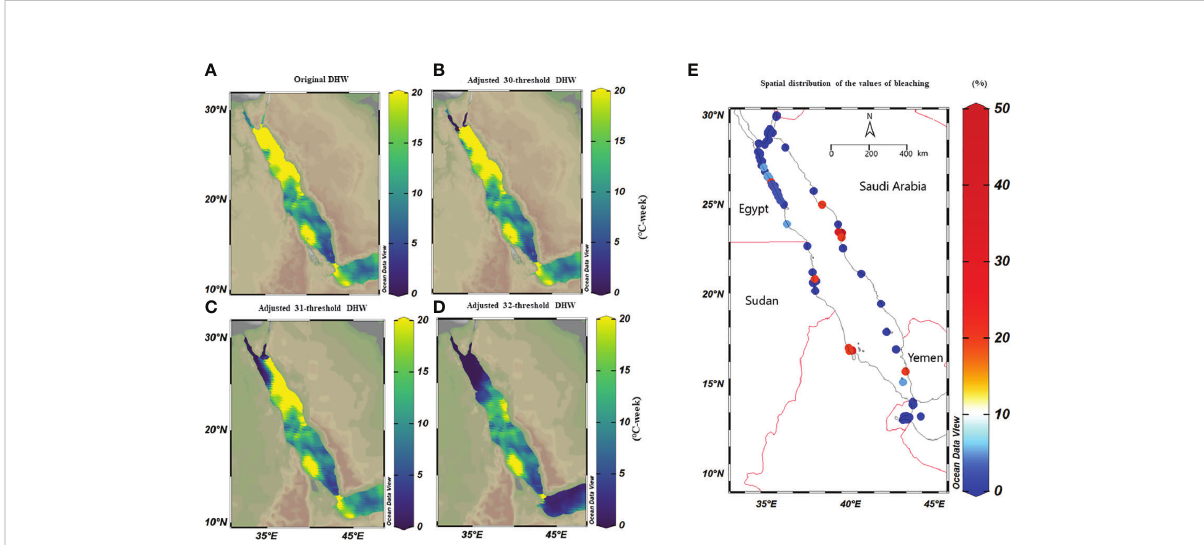
FIGURE 5 SpatialdistributionmapsofthemaximumDHWsbasedonclassical(i.e.,MMM+1°C)andadjustedthermalthresholdalongtheRedSeaover39years.We adjustedclassicalthresholdsusingaconditionthatanyvaluelessthan30°C,31°C,and32°C,foranygivenpixelaresetto30,31,and32°Crespectively. (A)